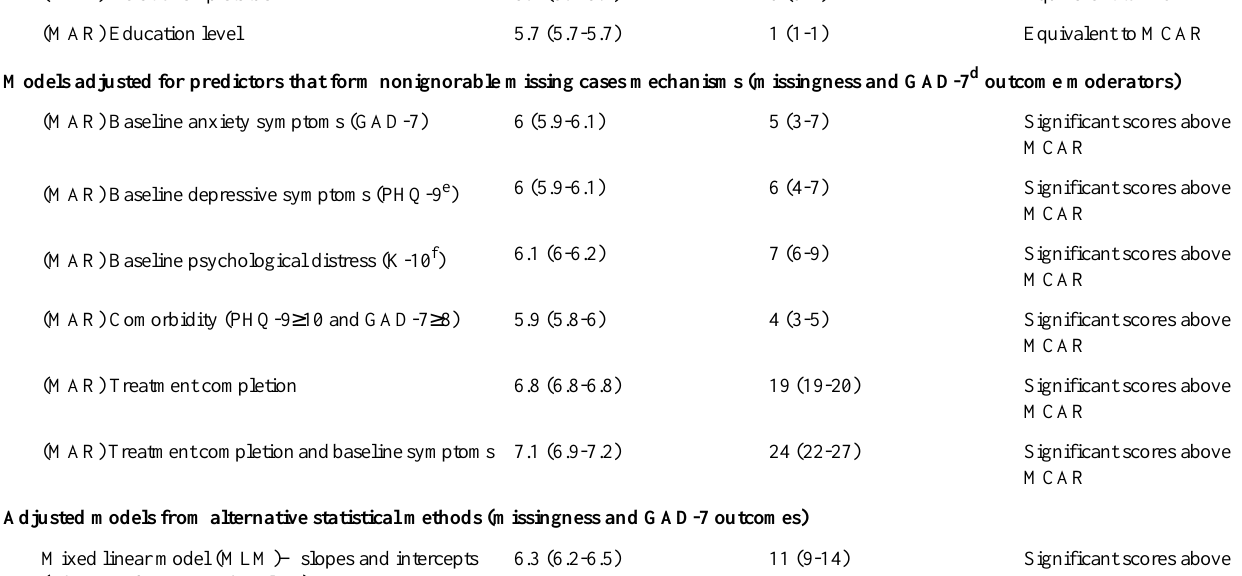
Models adjusted for predictors that do not form missing cases mechanisms